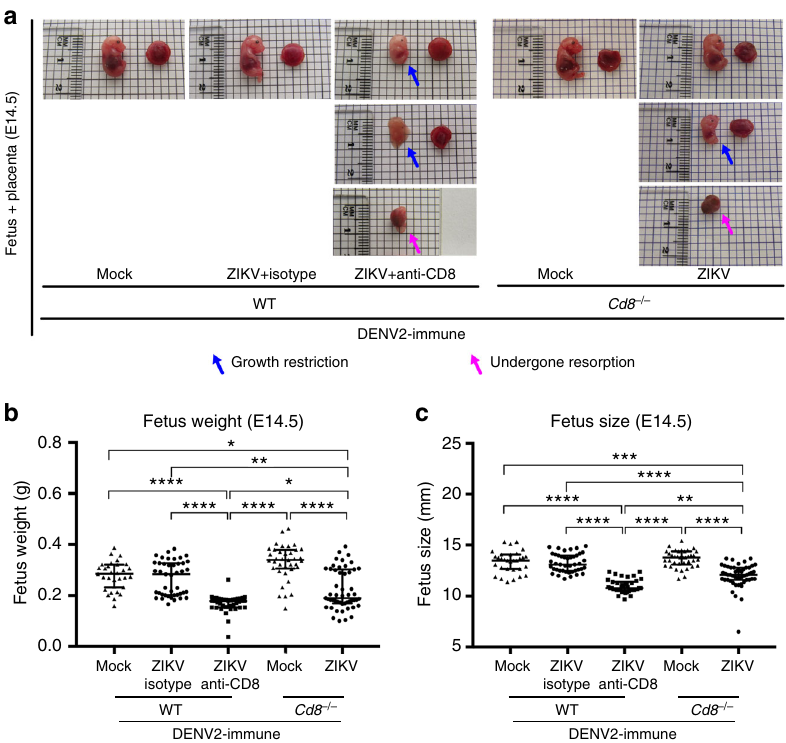
Fig. 4 Phenotype of fetuses from DENV2-immune Cd8 − / − dams treated with Ifnar1-blocking Ab. DENV2-immune Cd8 − / − dams were generated 30 days after DENV2 priming, treated with Ifnar1-blocking Ab, and challenged with ZIKV at E7.5 as described in Fig. 2. Tissues were harvested 7 days after ZIKV infection at E14.5. a Representative images of fetuses and placentas are shown. n = 37 fetuses from fi ve separate mothers (DENV2-immune-Mock), n = 51 fetuses from eight separate mothers (DENV2-immune-ZIKV). Numbers of WT fetuses and dams are described in Supplementary Fig. 3 (bottom panel). Blue and magenta arrows indicate the presence of fetal growth restriction and resorption, respectively. b Fetus weight and c size were recorded. Data were pooled from two independent experiments. Data were expressed as a median. * p < 0.05, ** p < 0.01, *** p < 0.001, **** p < 0.0001. Kruskal – Wallis test was used for b ,